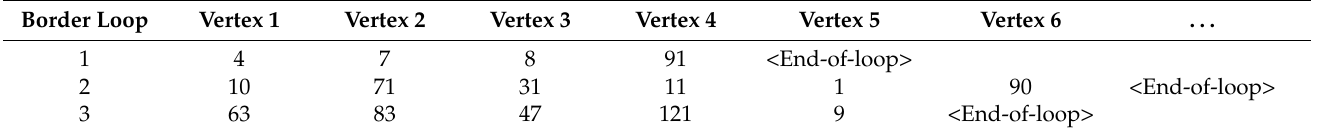
Table 5. BORDER table.